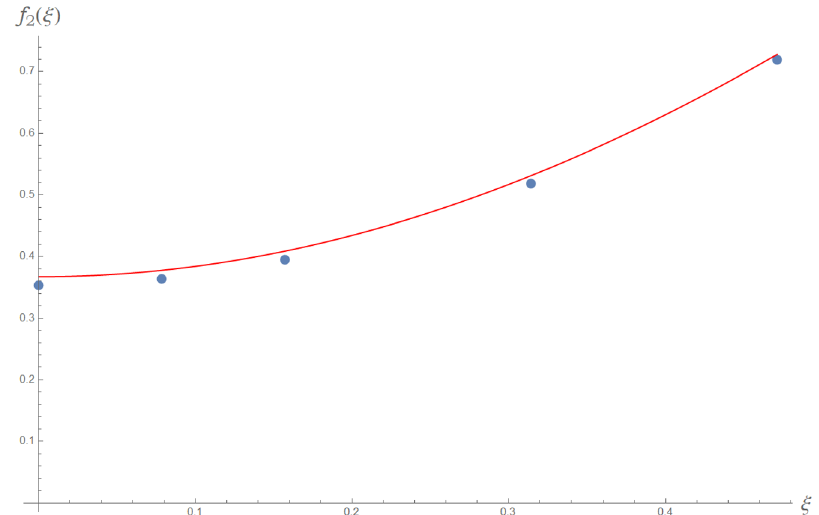
Figure 5 . Plot of the coefficient f 2 ( ξ ) . The red line is the analytic prediction from (3.30), and the blue dots are sample points for numerical simulations performed in Mathematica for ξ = 0 , π π , and 3 π 10 20